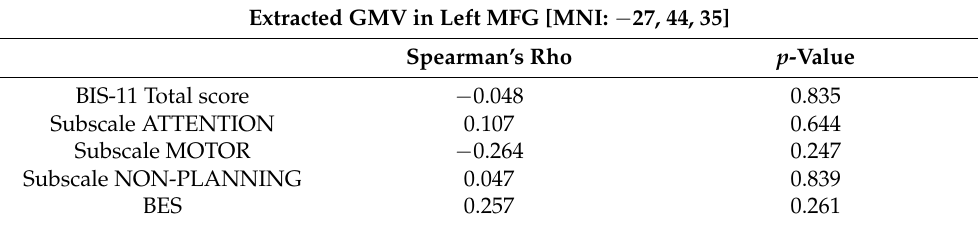
Table A1. Non-BE group: Correlation between BIS-11 and BES scores and GMV in the left MFG.